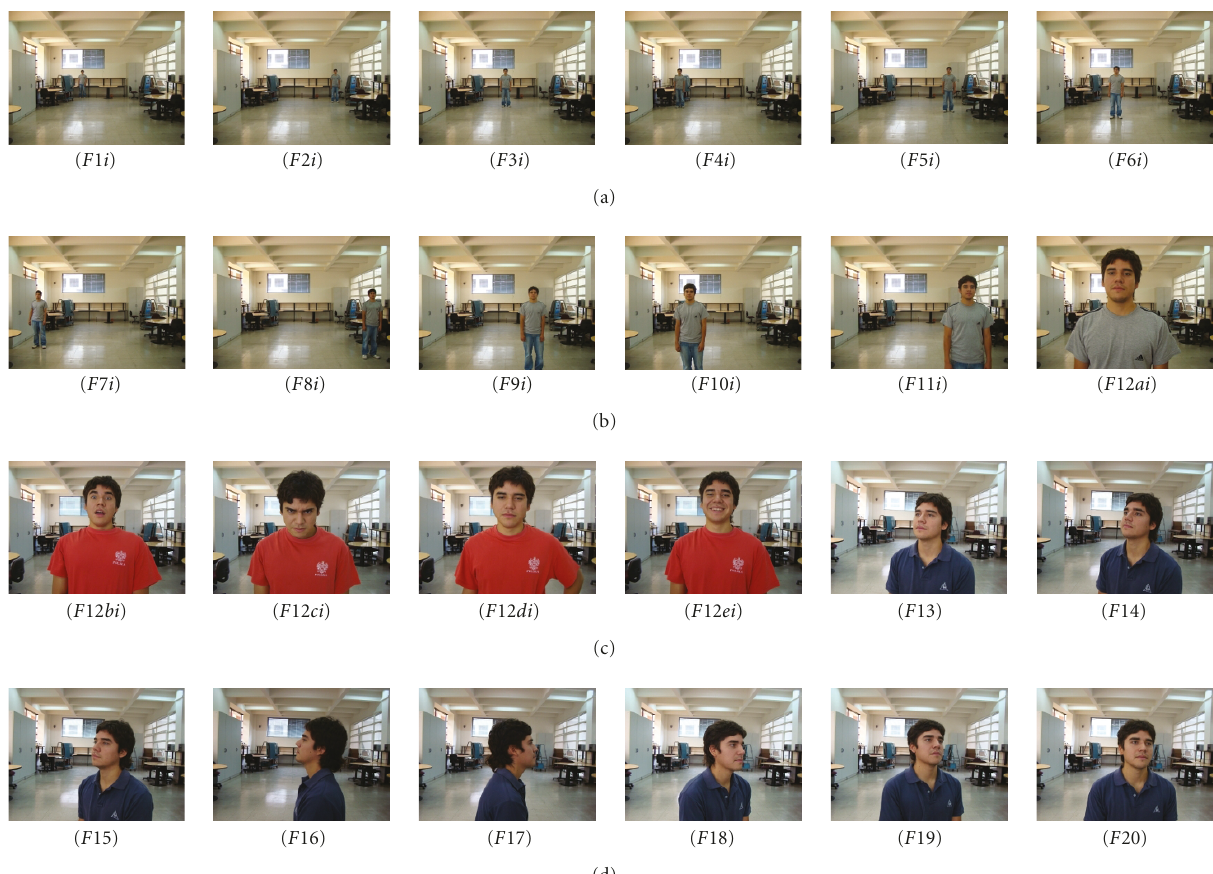
Figure 11: UCHFaceHRI database. Examples of 24 indoor images corresponding to an individual. The face-image F jki corresponds to an image taken acquisition point j (see Figure 10). i stands for indoor. In the case of the F12 k i images, the k index means: (a) Neutral expression, (b) Surprised, (c) Angry, (d) Sad, and (e) Happy.